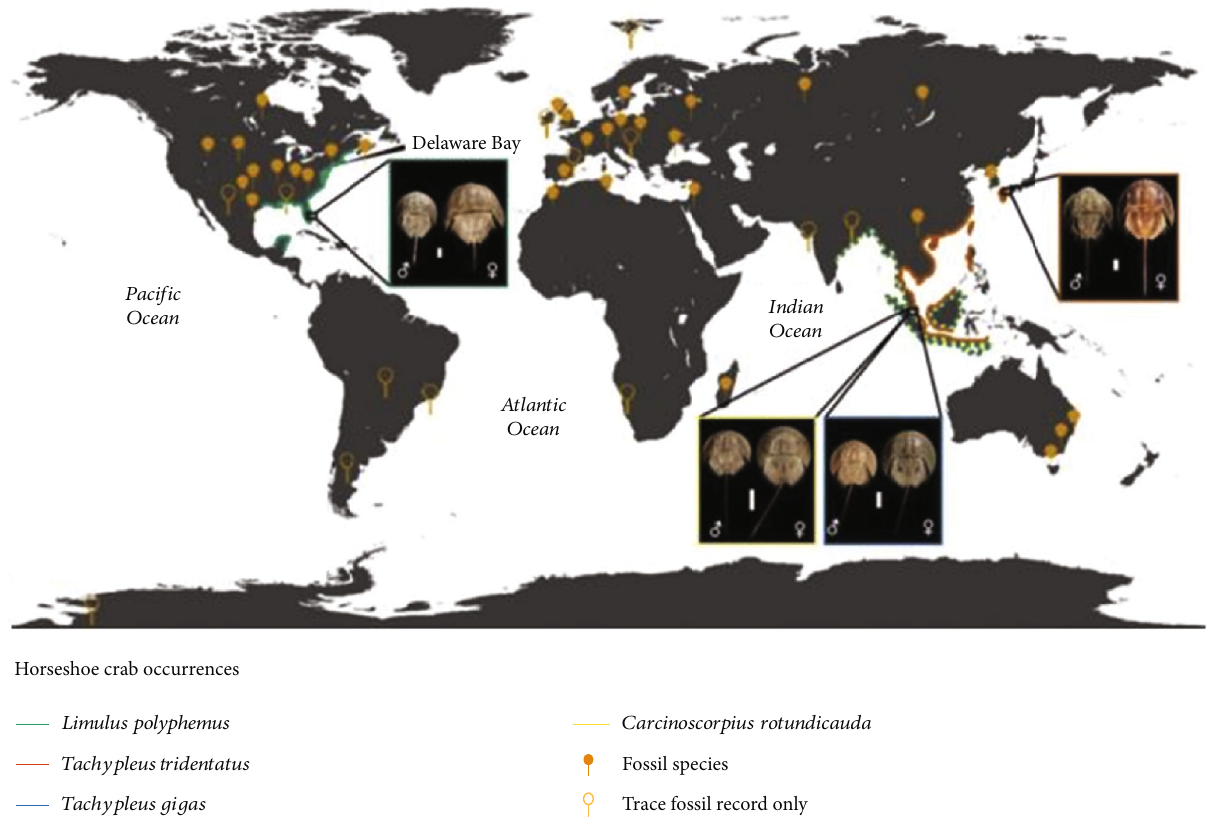
Figure 1: Horseshoe crab species distribution worldwide